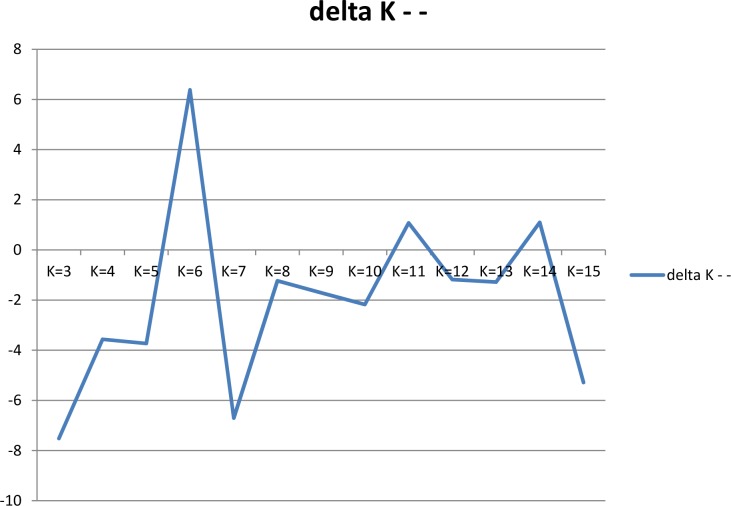
Ad-hoc statistic ∆K for K values ranging from 1 to 15.